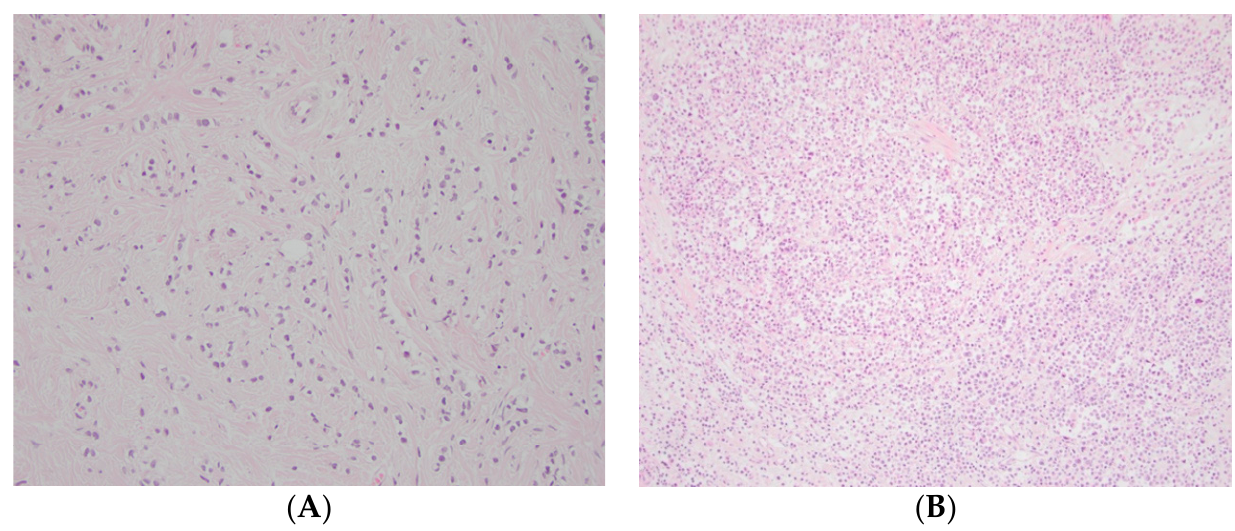
Figure 2. Representative photos of ( A ) high and ( B ) low intratumoral stromal content on hematoxylin–eosin-stained whole sections (magnification 100×).